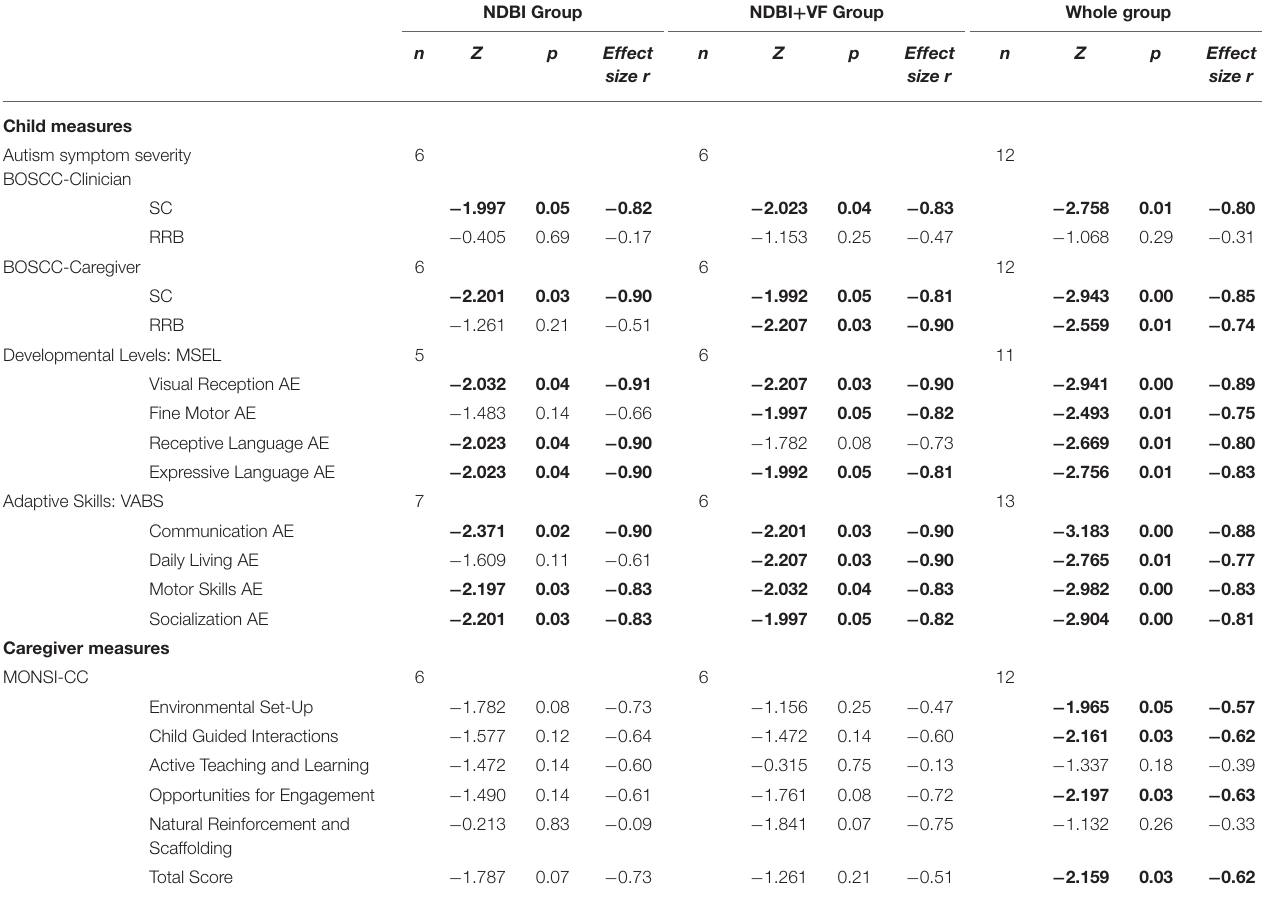
TABLE 2 | Wilcoxon signed-ranks test for change from Intervention Entry to